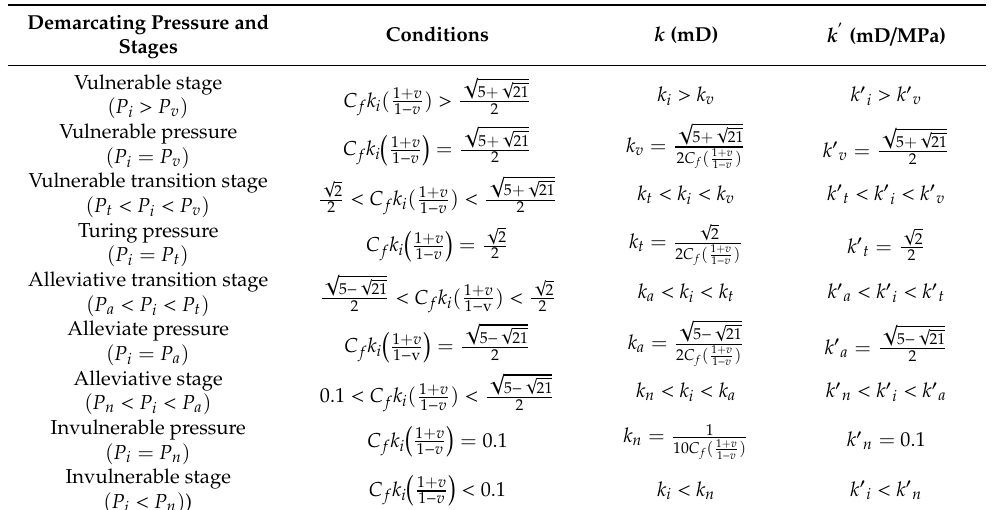
Table 1. Characteristics of reservoir permeability in single-phase water flow stage.